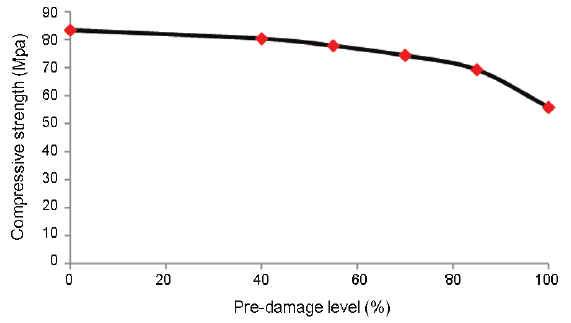
Fig. 5. Uniaxial compressive strength of CFRP-confined pre-damaged specimens